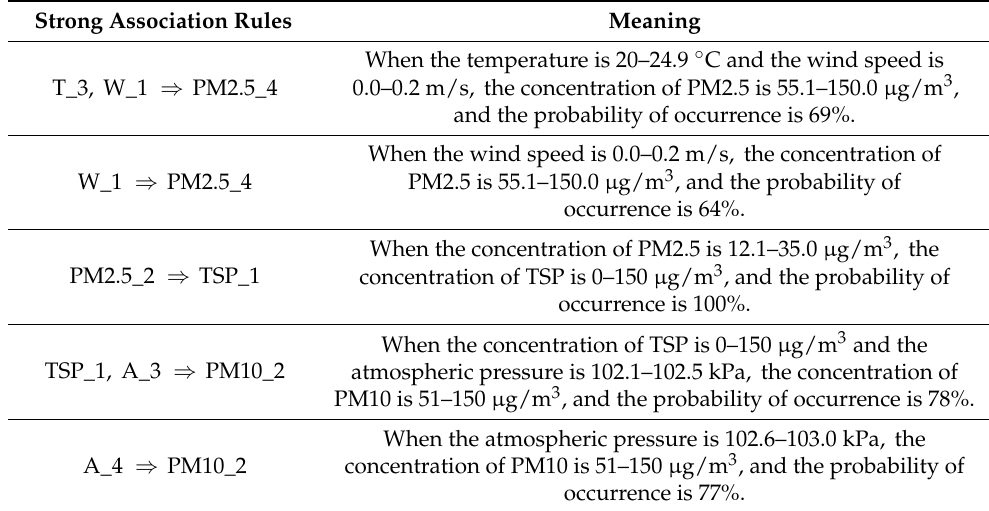
Table 12. Interpretation of strong association rules.